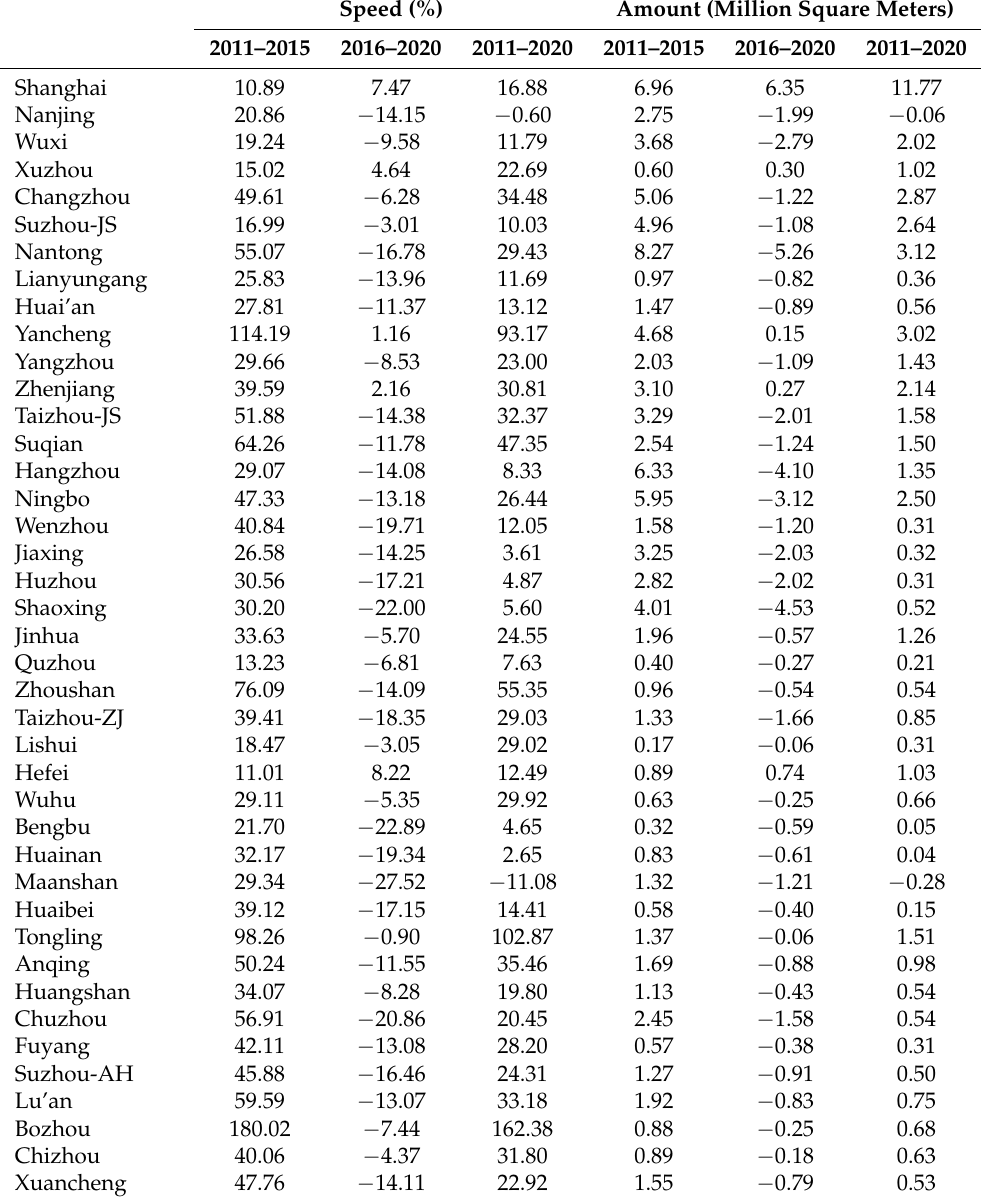
Table 2. The change speed and amount of real estate inventory in the Yangtze River Delta. Speed (%) Amount (Million Square